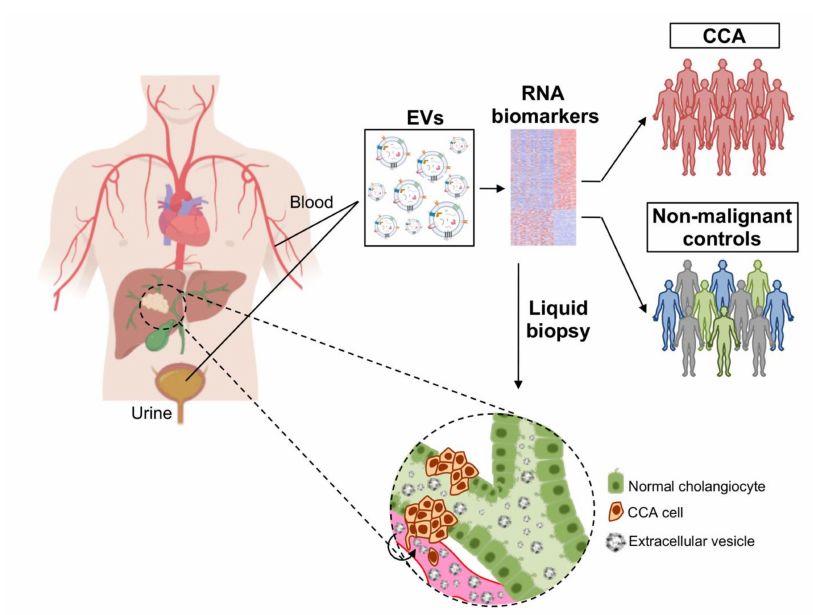
Figure 10. Novel liquid biopsy approach for cholangiocarcinoma. CCA tumor cells display distinct RNA expression profiles which are later released into circulation in EVs, containing potential biomarkers for CCA, that are amenable for detection in serum and urine, thus constituting a novel liquid biopsy